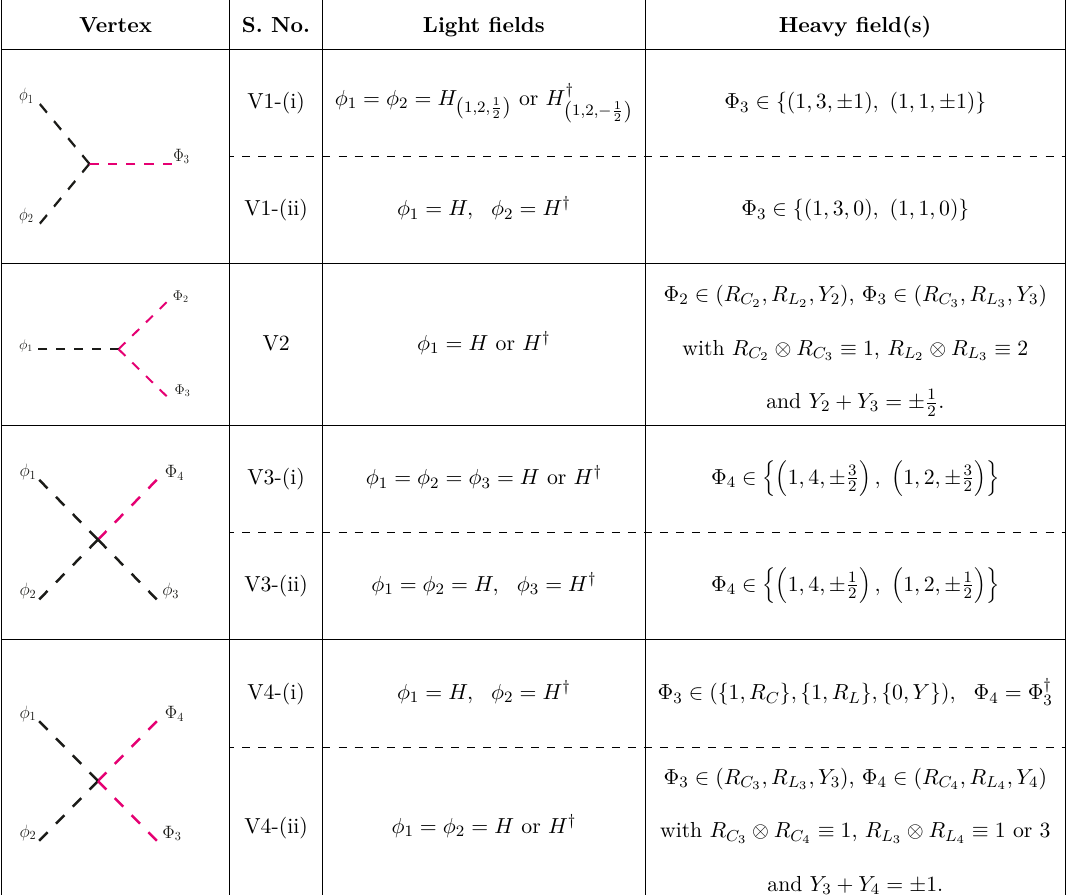
Table 2 . Allowed heavy field representations when the light degrees of freedom are the Standard Model ones. Here, φ denote the SM Higgs and Φ the various heavy scalars. R i i representations under SU(3) and SU(2) gauge groups and Y refers to the U(1) C L of the field. Their appearance describes the cases where the vertex is not constituted by a unique heavy field representation but can involve a plethora of